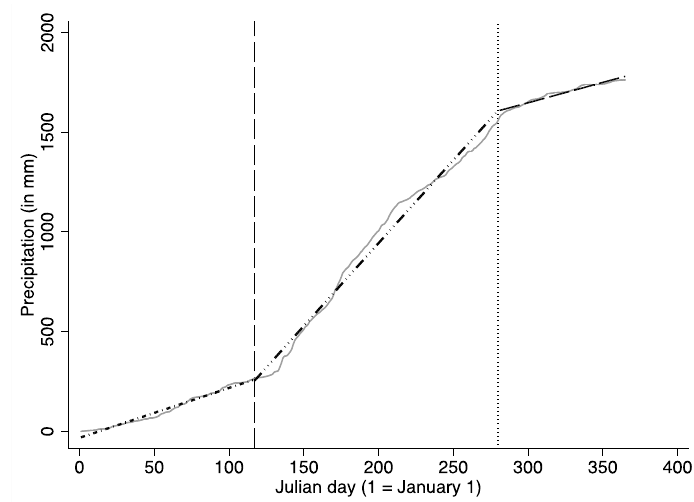
Figure 1. This graph illustrates how the cumulative precipitation function is used to estimate the onset and retreat dates of the monsoon for each province in each year from 1980 to 2011. It shows the onset (dashed grey vertical line) and retreat (dotted grey vertical line) of the monsoon in Yunnan province in 1990. The slope of the cumulative precipitation function changes significantly at these two points. These two points mark the estimated onset and retreat of the East Asian monsoon in Yunnan province in the example year 1990. The dashed lines overlaid on top of the cumulative precipitation function show the slope of each section of the function as estimated by “Segmented”.